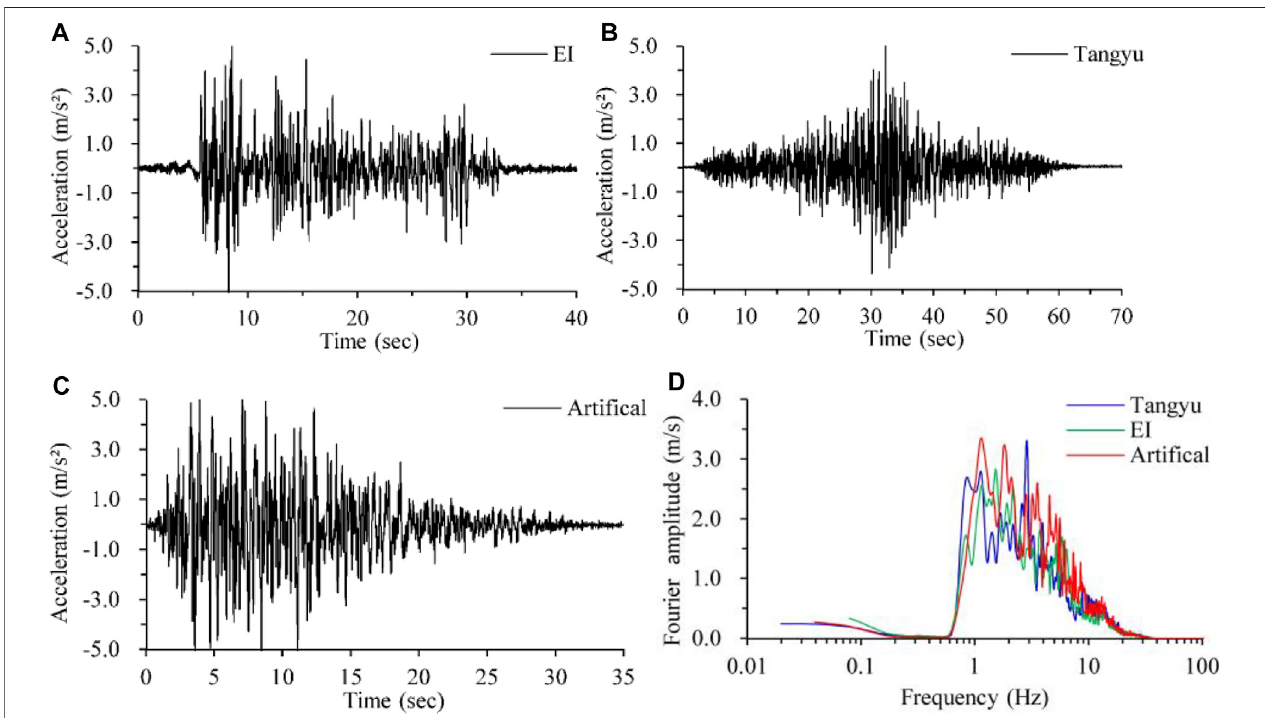
FIGURE6| Conditionoftheexcitationwaves. (A) TimehistoryofEI-Centrowave. (B) TimehistoryofTangyuwavesfromtheWenchuanearthquake(datasources: National Earthquake Data Center of China). (C) Time history of the arti fi cial wave. (D) Fourier spectrum of the excitation wave.